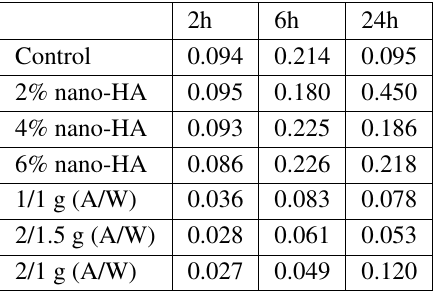
Table 3. Table 1.Residual monomer content calculated as percentage of MMA by mass of thespecimens of all compositions after different time